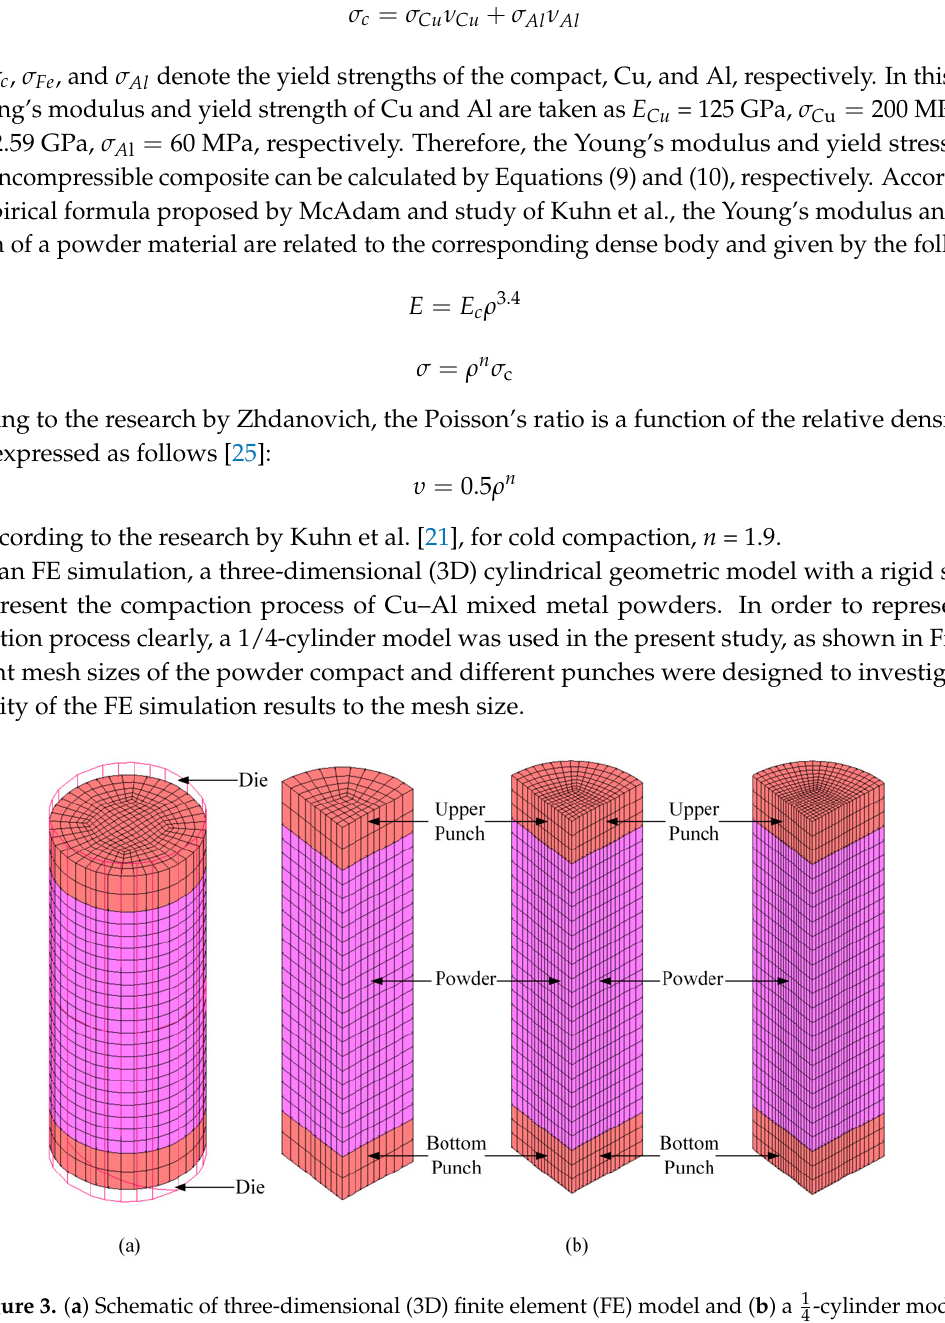
-cylinder model 4